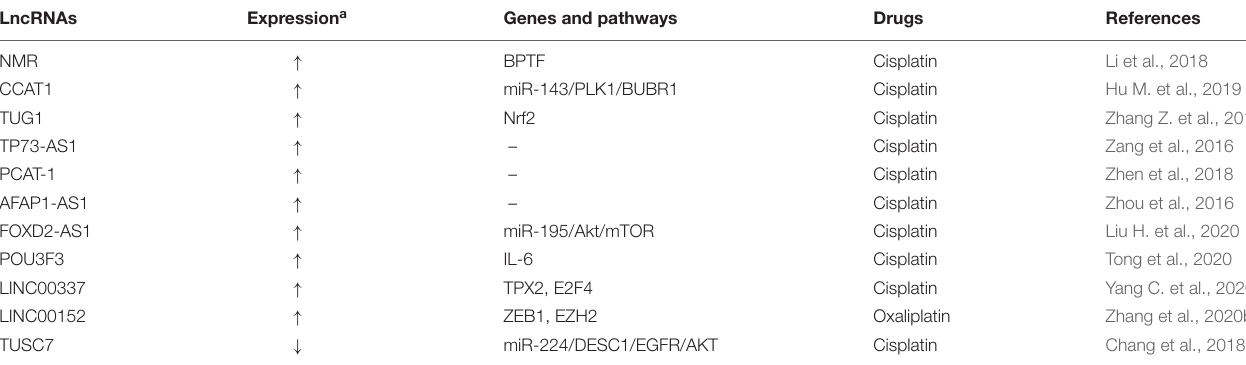
TABLE 4 | Long non-coding RNAs (lncRNAs) and platinum drugs resistance in esophageal cancer.